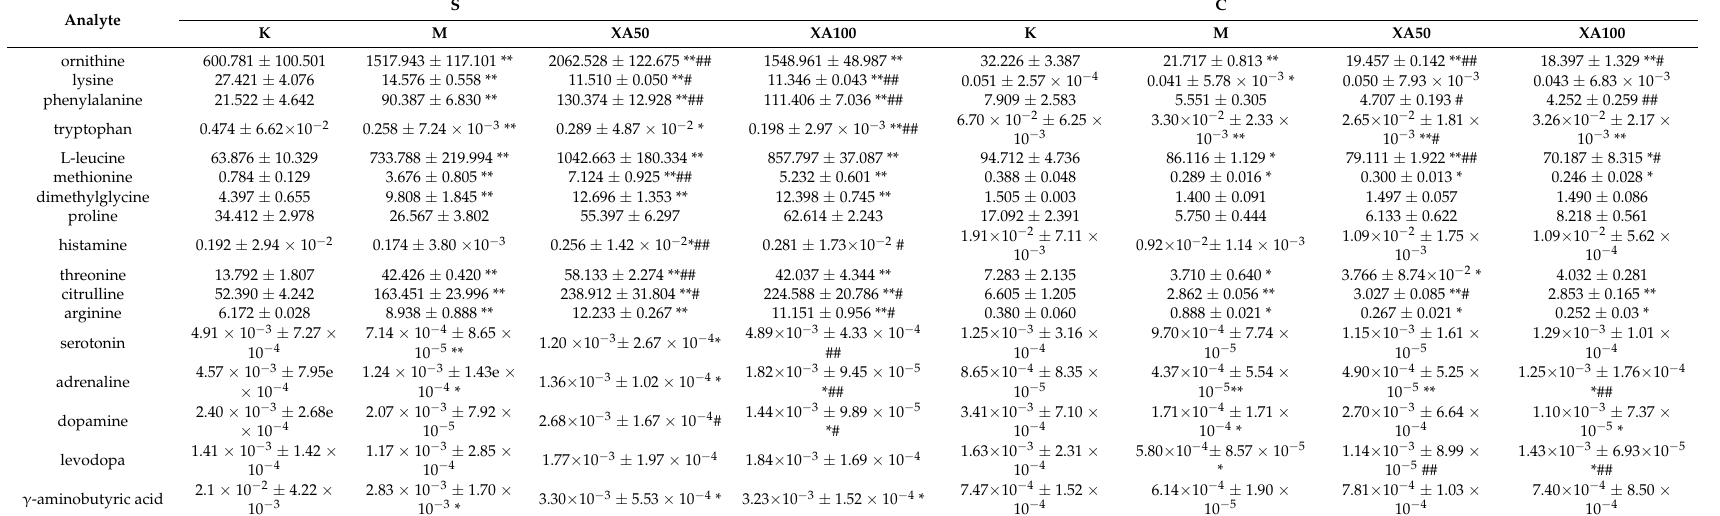
Table 6. Results of relative quantification of neurotransmitters in cell supernatants and cells ((A x /A i ) ×